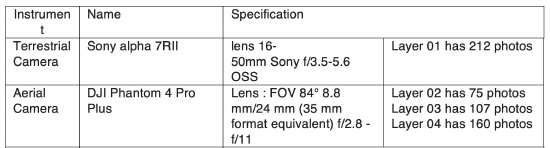
Figure 7. Camera poses of GB Data Set.